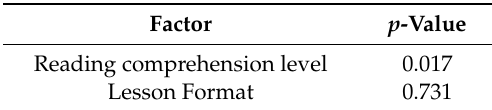
Table 6 details the p -values obtained from Welch’s test. Table 6. Welch’s t-test on time taken to complete exam based on reading comprehension level and lesson